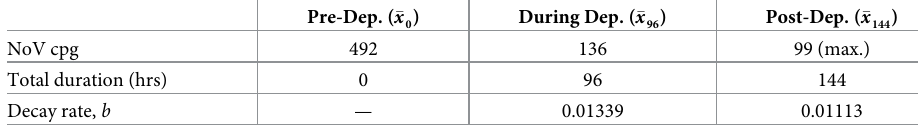
Table 2. Depuration decay rates for NoV derived from data in Dore´ et al